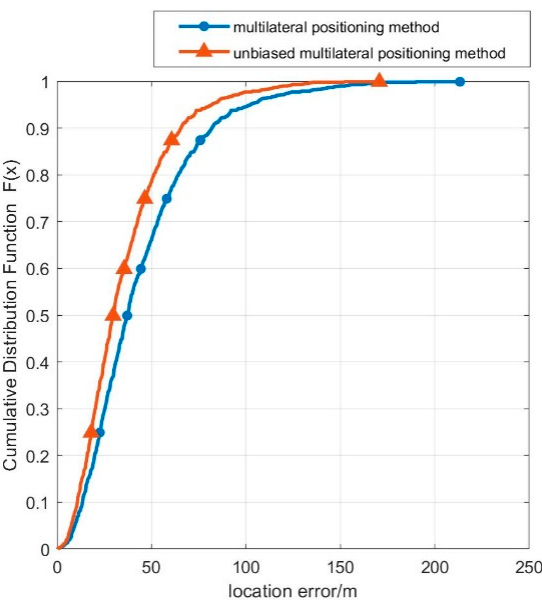
Figure 3. Two algorithm positioning scatter plots.